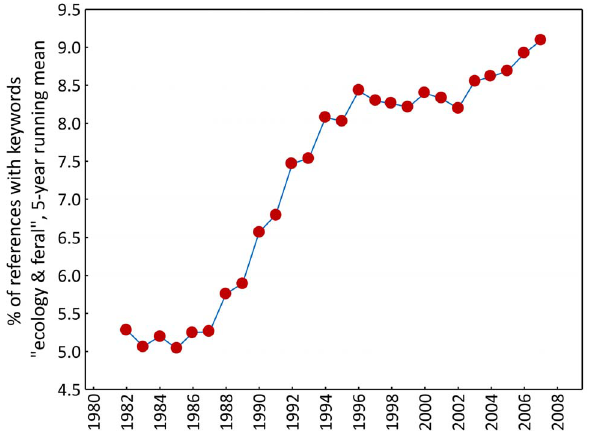
Figure 1. Temporal trend in the percentage of primatological publications dealing with aspects of primate ecology over the period 1980–2009. Dots represent 5-year running means; therefore, 1980, 1981, 2008 and 2009 are not represented by a dot.